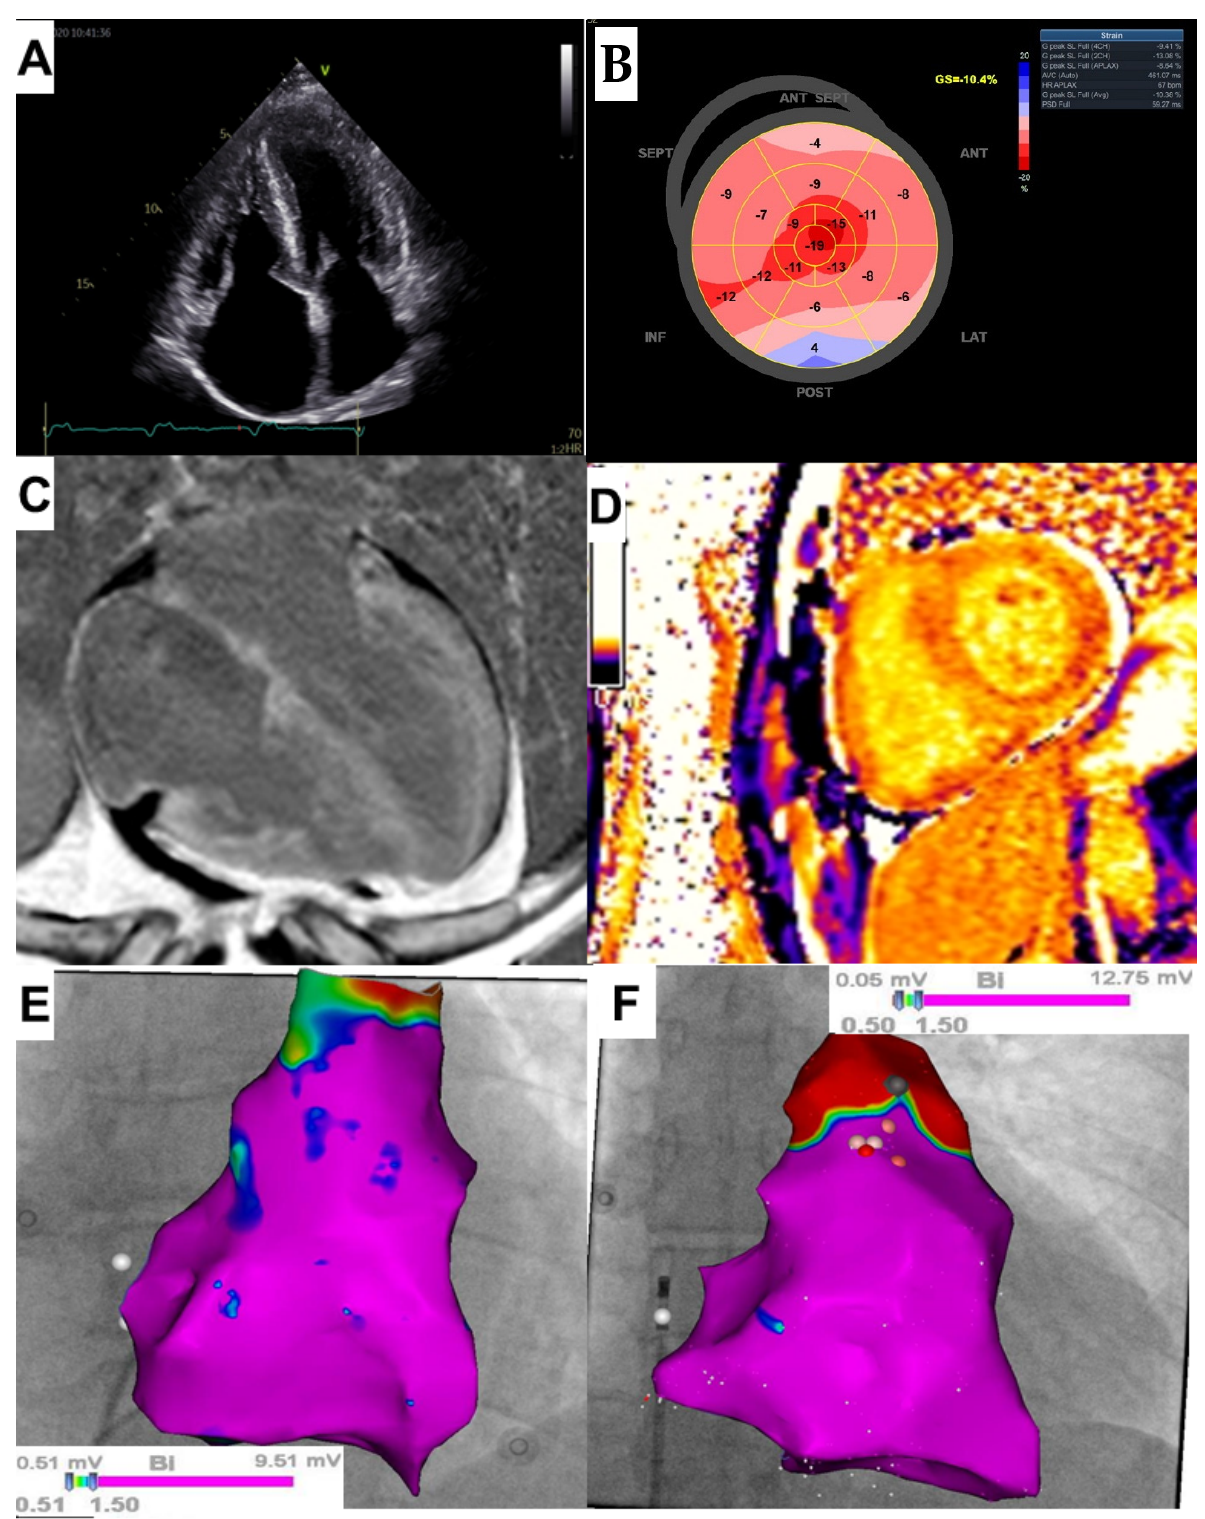
Figure 1. ( A ) Transthoracic echocardiography (TTE Vivid S95, GE Healthcare, Chicago, IL, USA): 4- chamber apical view demonstrating ventricular hypertrophy and atrial enlargement; ( B ) TTE (Vivid S95, GE Healthcare, Chicago, IL, USA): Left ventricular (LV) global longitudinal strain showing LV “apical sparring” pattern; ( C ) Cardiac magnetic resonance imaging (cMRI; Siemens Aera, 1.5 T, Erlangen, Germany): Phase-sensitive inversion recovery sequence showing the extent and